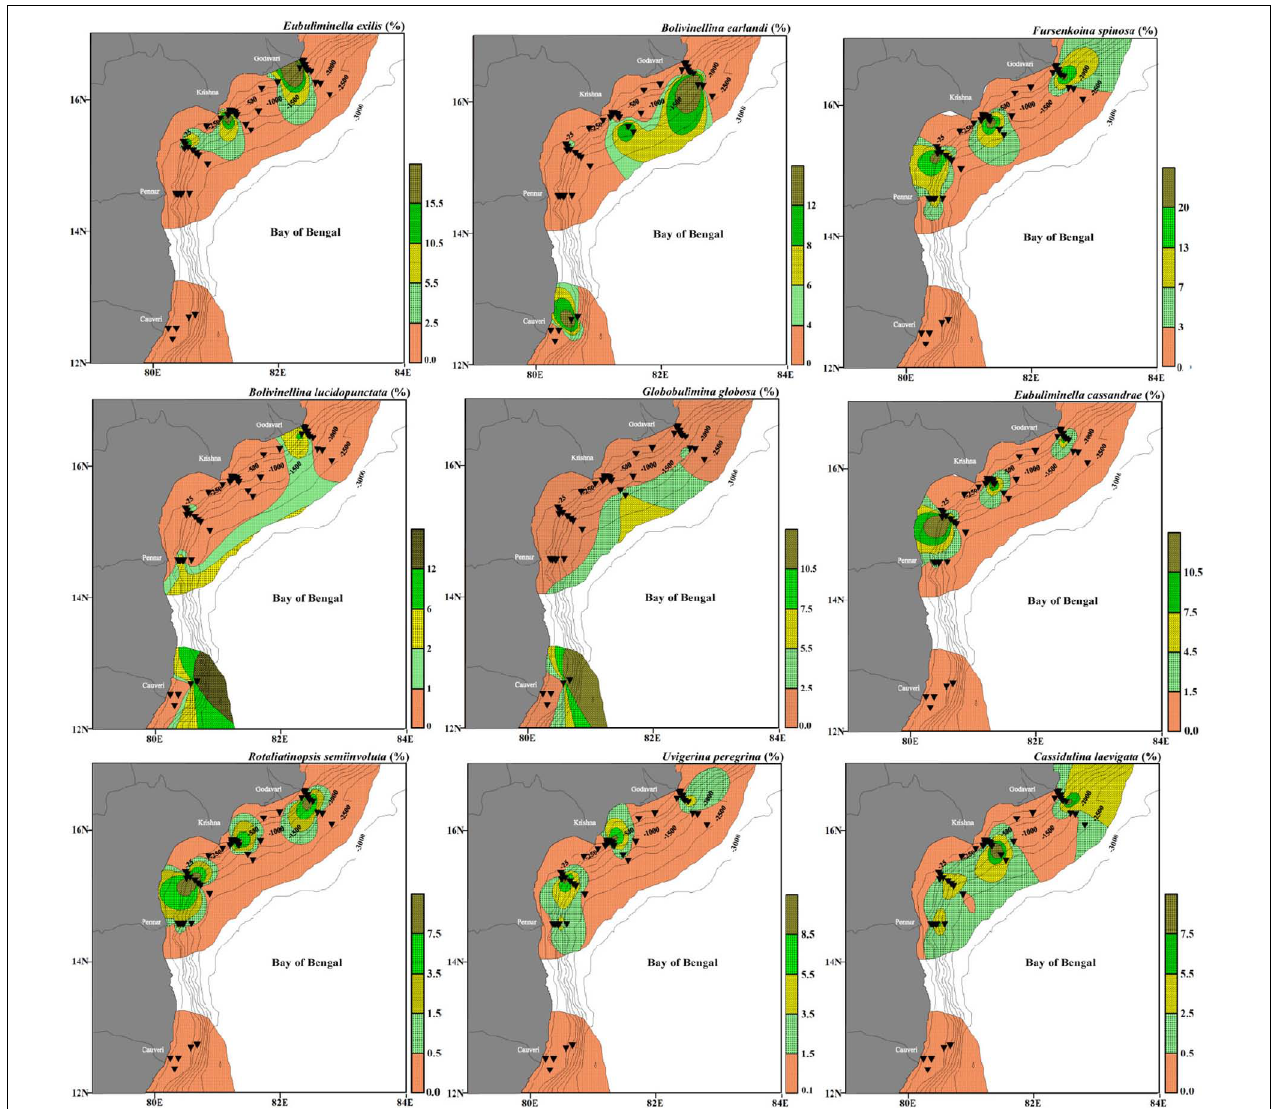
FIGURE 11 | Relative abundance of species representing intermediate depth assemblage (Assemblage II), having significant negative correlation with dissolved oxygen and positive correlation with organic carbon. Eubuliminella exilis, Bolivinellina earlandi , Fursenkoina spinosa , Bolivinellina lucidopunctata , Globobulimina globosa, Fursenkoina spinosa, Eubuliminella cassandrae, Uvigerina peregrina, Rotaliatinopsis semiinvoluta, and Cassidulina laevigata. The stations are marked by black inverted triangles. The thin black lines mark the bathymetric